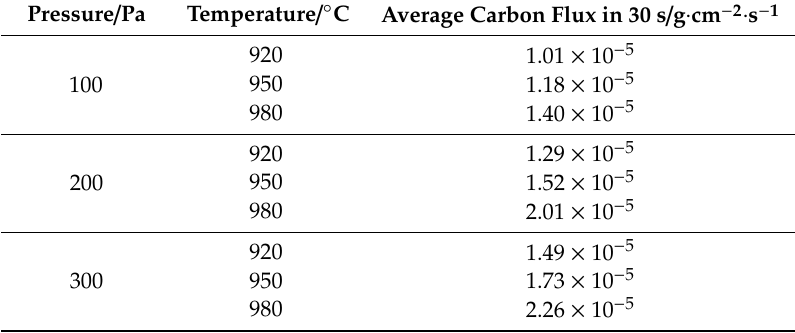
Table 3. Effect of carburizing temperature and pressure on average carbon flux of 16Cr3NiWMoVNbE steel.